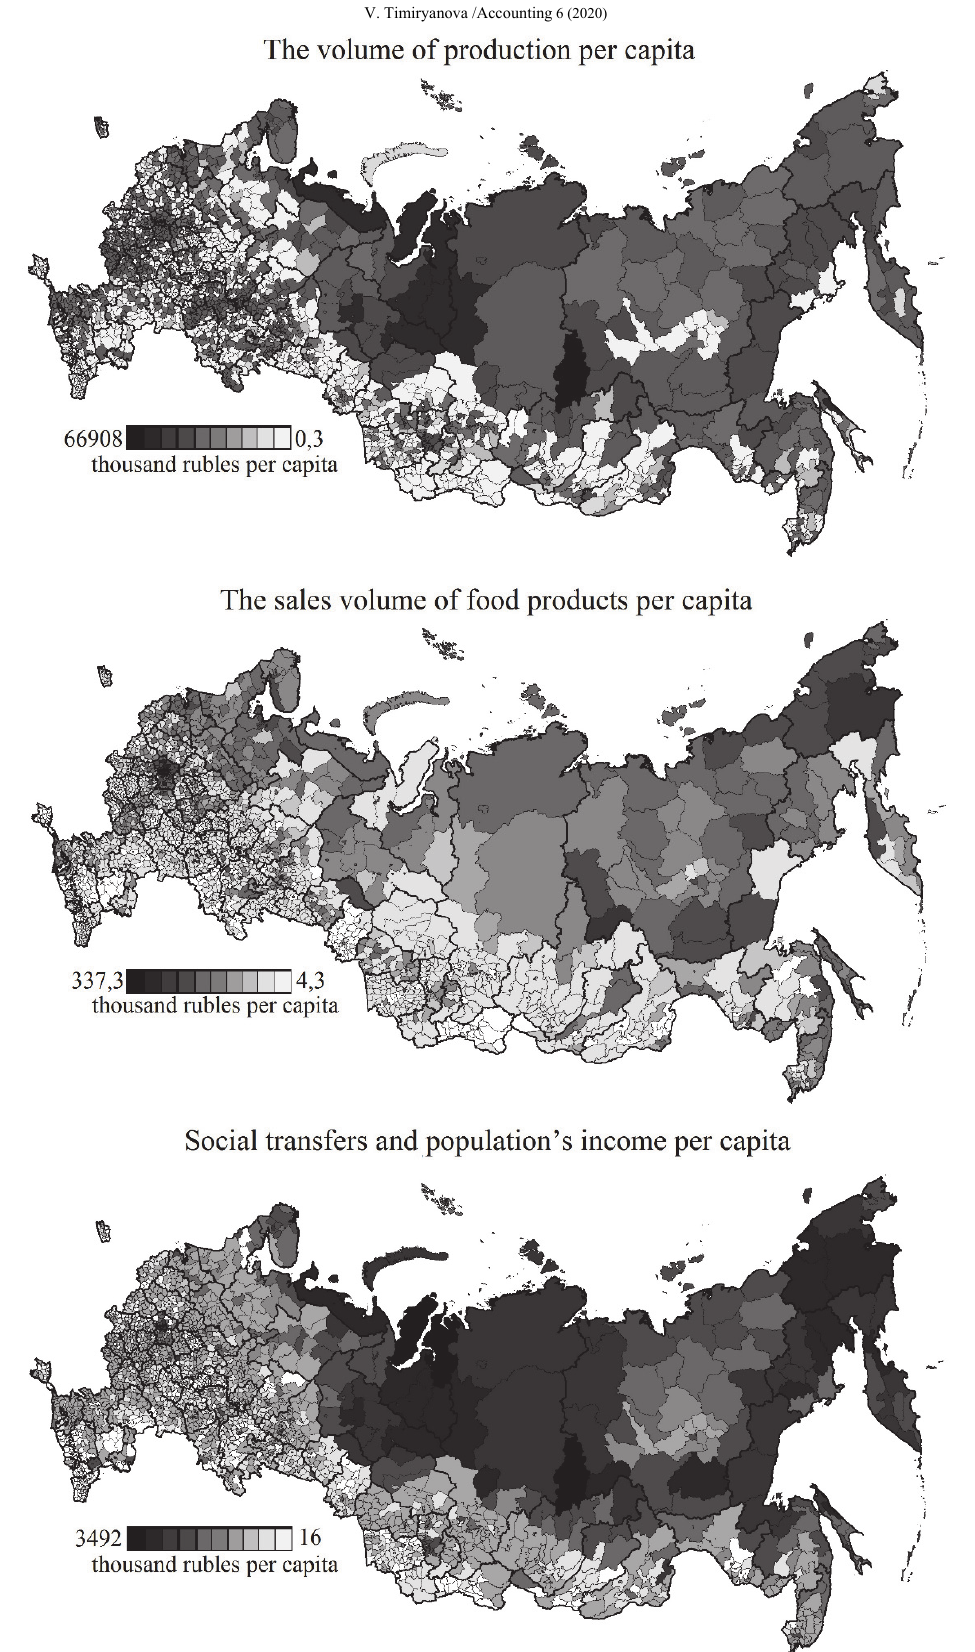
Fig. 2. The volume of production, social transfers and population’s income, the sales volume of food